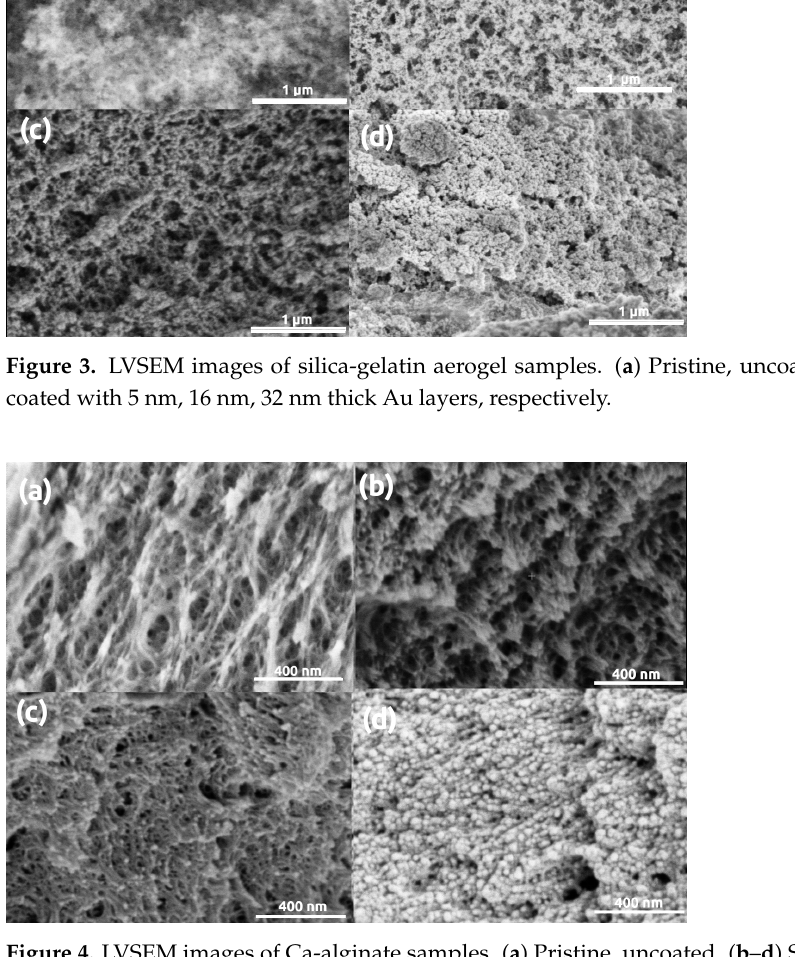
Figure 4. LVSEM images of Ca-alginate samples. ( a ) Pristine, uncoated. ( b – d ) Sputter coated with 5 nm, 16 nm, 32 nm thick Au layers,